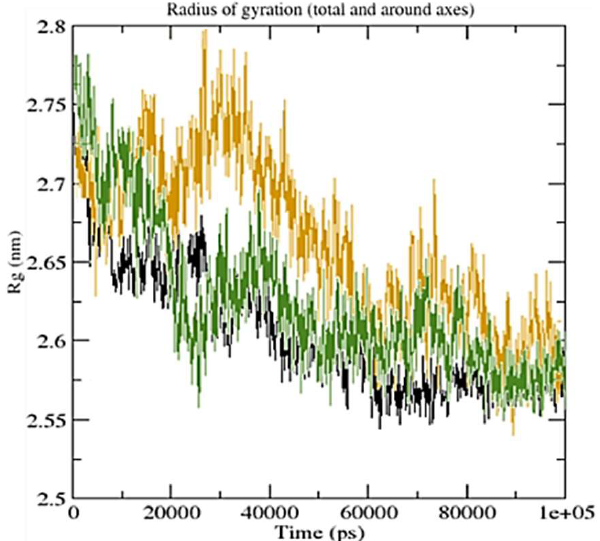
Figure 8. The Rg data over 100 ns simulation time. Black color represents serotonin receptor alone, orange color represents the BarS complex, and green color represents the BarCS complex.